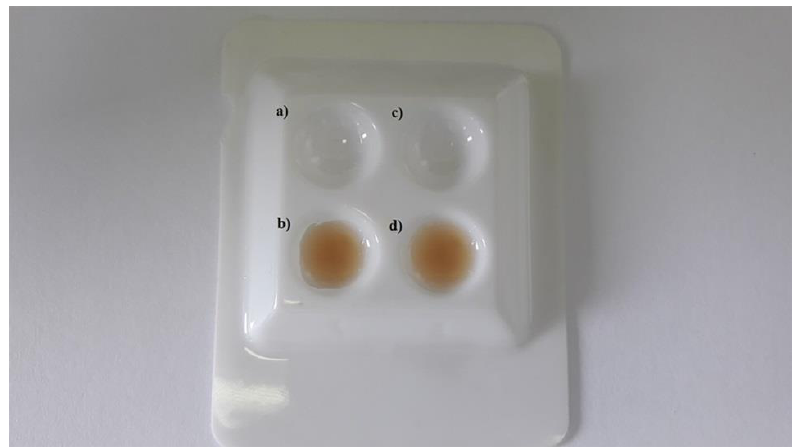
Figure 1. Observation of change in colour of the polymerised experimental preparation ( a ) before the addition of eosin and ( b ) after the addition of eosin, as well as of Icon solution ( c ) before the addition of eosin and ( d ) after the addition of eosin.